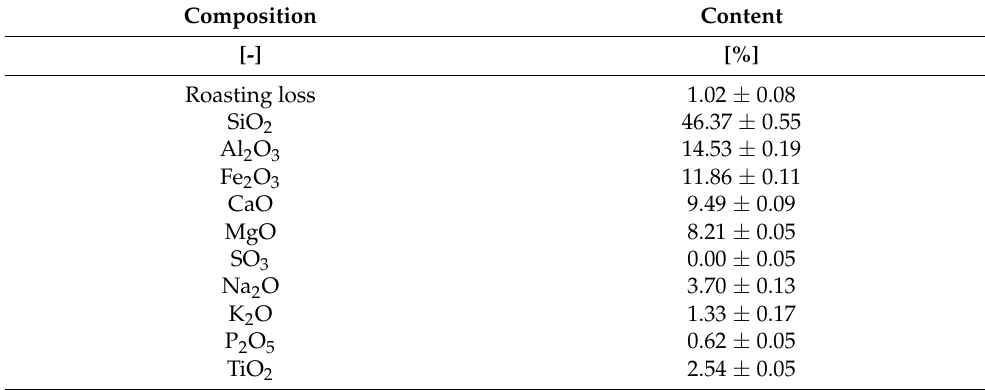
Table 3. Basalt B chemical composition.